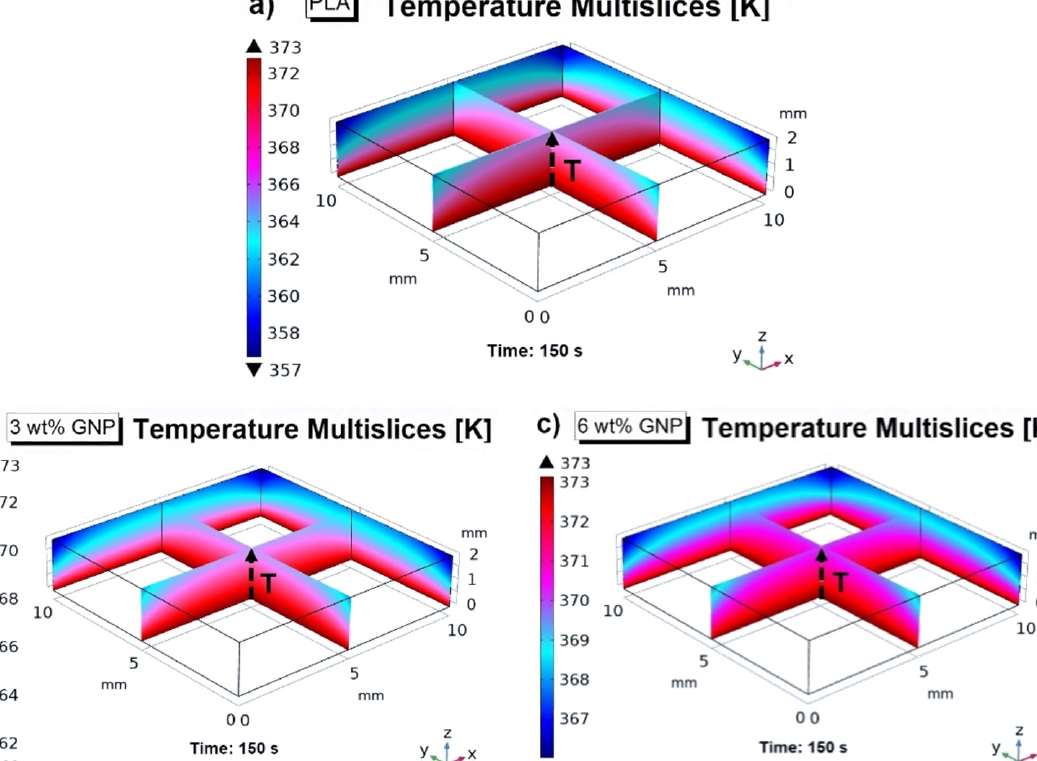
Figure 10. Temperature multislices evaluated at steady-state condition ( t = 150 s) and at temperature value of 373.15 K relatively to PLA, PLA/3 wt% GNPs, and PLA/6 wt% GNPs in ( a – c ), respectively.